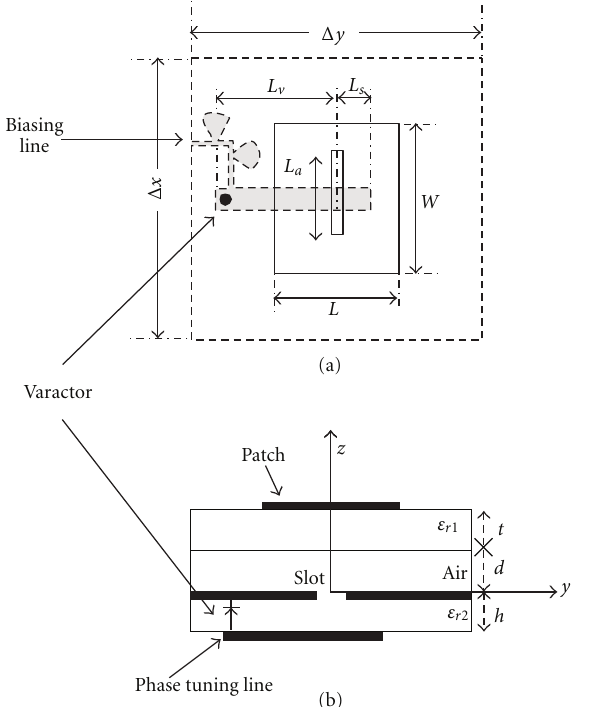
Figure 1: Reflectarray element configuration: (a) top view; (b) side view.